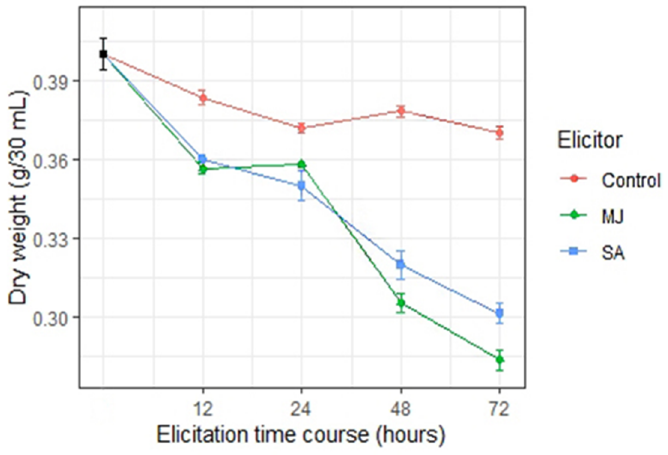
Figure 3. Effects of methyl jasmonate (MJ) and salicylic acid (SA) on cell growth of Greater Celandine at different time courses (12, 24, 48, and 72 h). Dry weight of cells after 14 days of the culture cycle (stationary growth phase) is represented by the black point. Non-elicited cells were used as control. Each data represents the mean value of six replications and error bars represent mean ± standard deviation